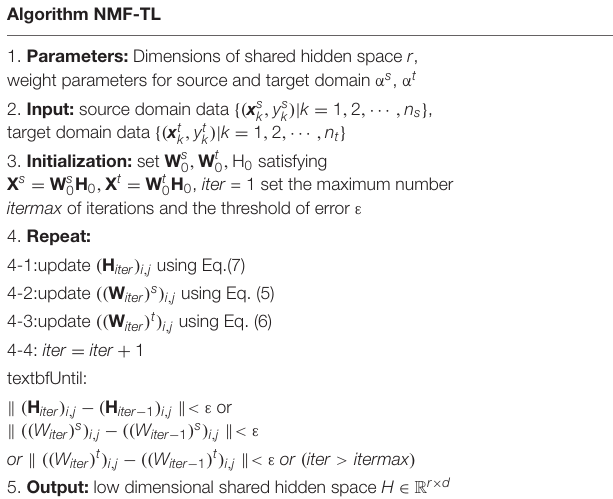
TABLE 1 | The description of the low-dimensional shared hidden subspace